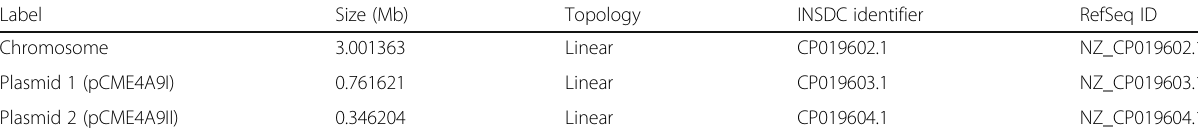
Table 3 Summary of genome: one chromosome and two plasmids